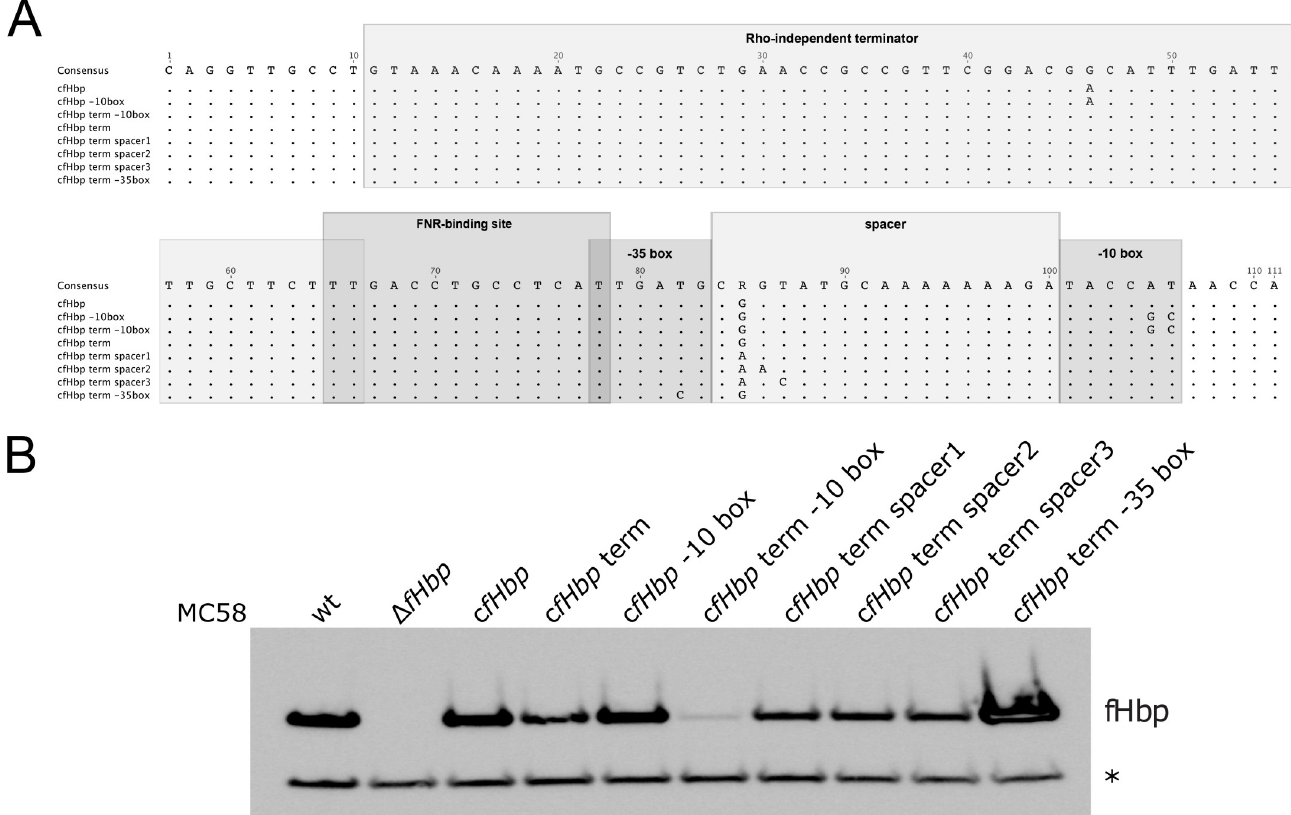
Fig 3. Polymorphisms that regulate fHbp expression. (A) Multiple sequence alignment of the MC58 fHbp intergenic region (spanning from the translational stop codon of cbbA and the transcriptional start site of fHbp ) and of the mutants of the regulatory elements generated by site-directed mutagenesis. The consensus sequence is at the top of the aligned sequences. Dots represent conserved positions and mismatches are indicated with nucleotides. The regions of the regulatory elements are indicated and boxed in shades of grey. (B) Western blot analysis representative of three biological replicates on the set of mutants generated and grown overnight in GC agar at 37˚C. The protein YraP, GNA2091, was used as a loading control and it is indicated with an